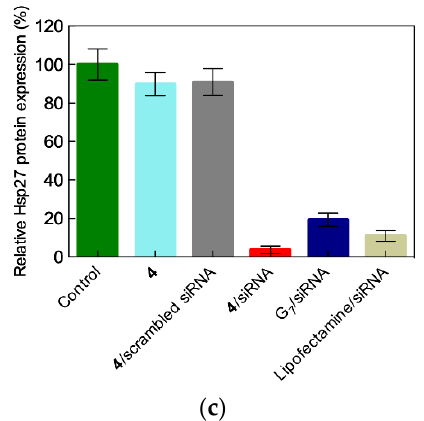
Figure 4. Self-assembled dendron-mediated siRNA delivery and gene silencing of Hsp27 ( a ) and TCTP proteins ( b ) in human prostate cancer PC-3 (solid bars) and C4-2 (patterned bars) cell lines (N / P = 10). Control: Untreated cells. The results obtained from non-self-assembling dendrons 1 , 7 and 8 are also shown for negative-control purposes. ( c ) Expression of Hsp27 in PC-3 cells treated with 50 nM siRNA delivered by self-assembled dendron 4 (N / P = 10), by Lipofectamine, and by the high-generation covalent triethanolamine (TEA)-core PAMAM-based dendrimer G 7 . Control: Untreated cells. Negative controls: Self-assembled dendron 4 alone and a scrambled (i.e., non-silencing) siRNA sequence. The expression levels of Hsp27 and TCTP proteins were quantified by western blots 72 h post treatment using vinculin as the control. Adapted from [7] with the permission of John Wiley and Sons, 2016.